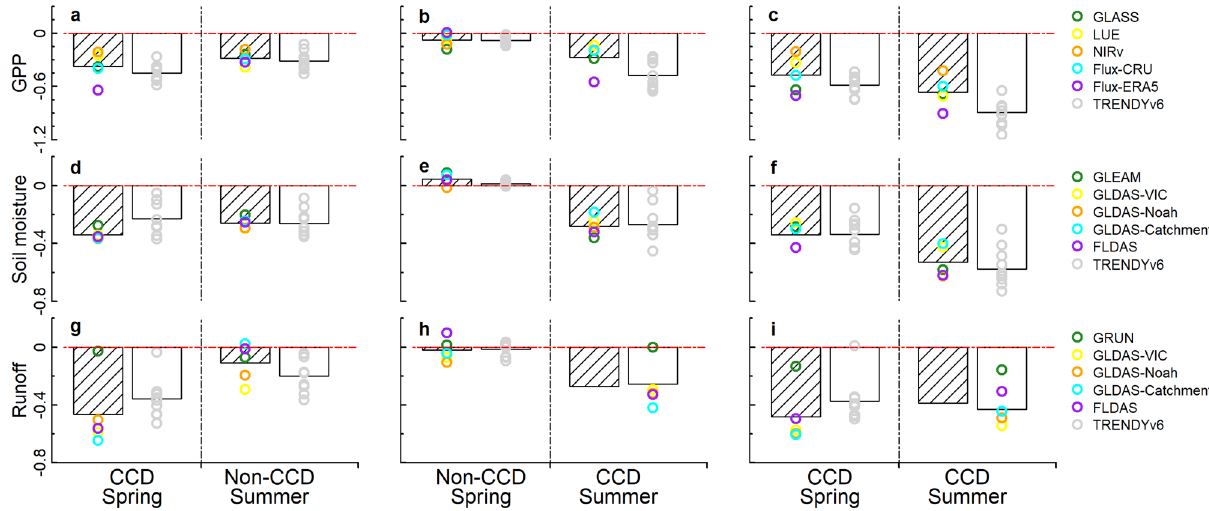
Fig. 5 The effects of CCD events on vegetation productivity and hydrological variables in mid-to-high latitudes. a – c The average standardized anomalies (z-score) of GPP during CCD spring but subsequent non-CCD summer ( a ), non-CCD spring but subsequent CCD summer ( b ), and consecutive CCD spring and summer ( c ) for areas in Fig. 2b where summer vegetation responds negatively ( r ≤ − 0.22) to spring CCD climate conditions. d – f The same as a – c , but for soil moisture. g – i The same as a – c , but for runoff. The bar plots with dash lines (without dash line) indicate the average anomalies of multiple observation-based (model-based) products, and the circles indicate the average anomalies of each product. For details on data see Fig.